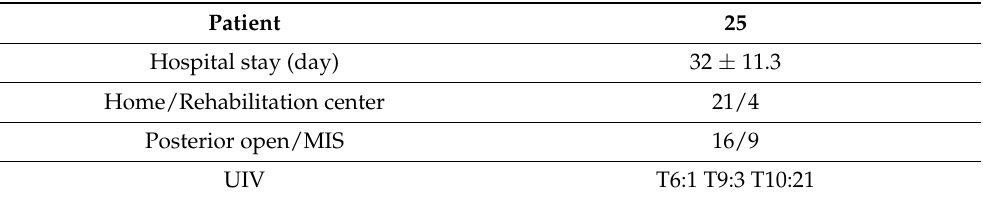
Table 2. Clinical results.